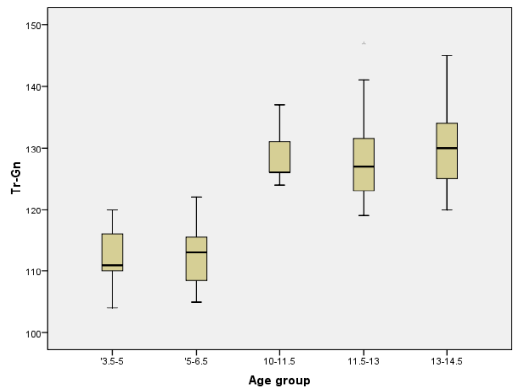
Figure 7. Boxplot for N-Gn values.